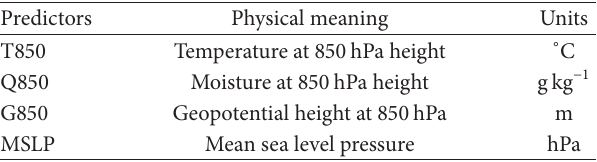
Table 1: Four variable predictors from the CFSR and CFSv2-Interim forecast dataset. Predictors Physical meaning Units T850 Temperature at 850 hPa height ∘ C Q850 Moisture at 850 hPa height gkg −1 G850 Geopotential height at 850 hPa m MSLP